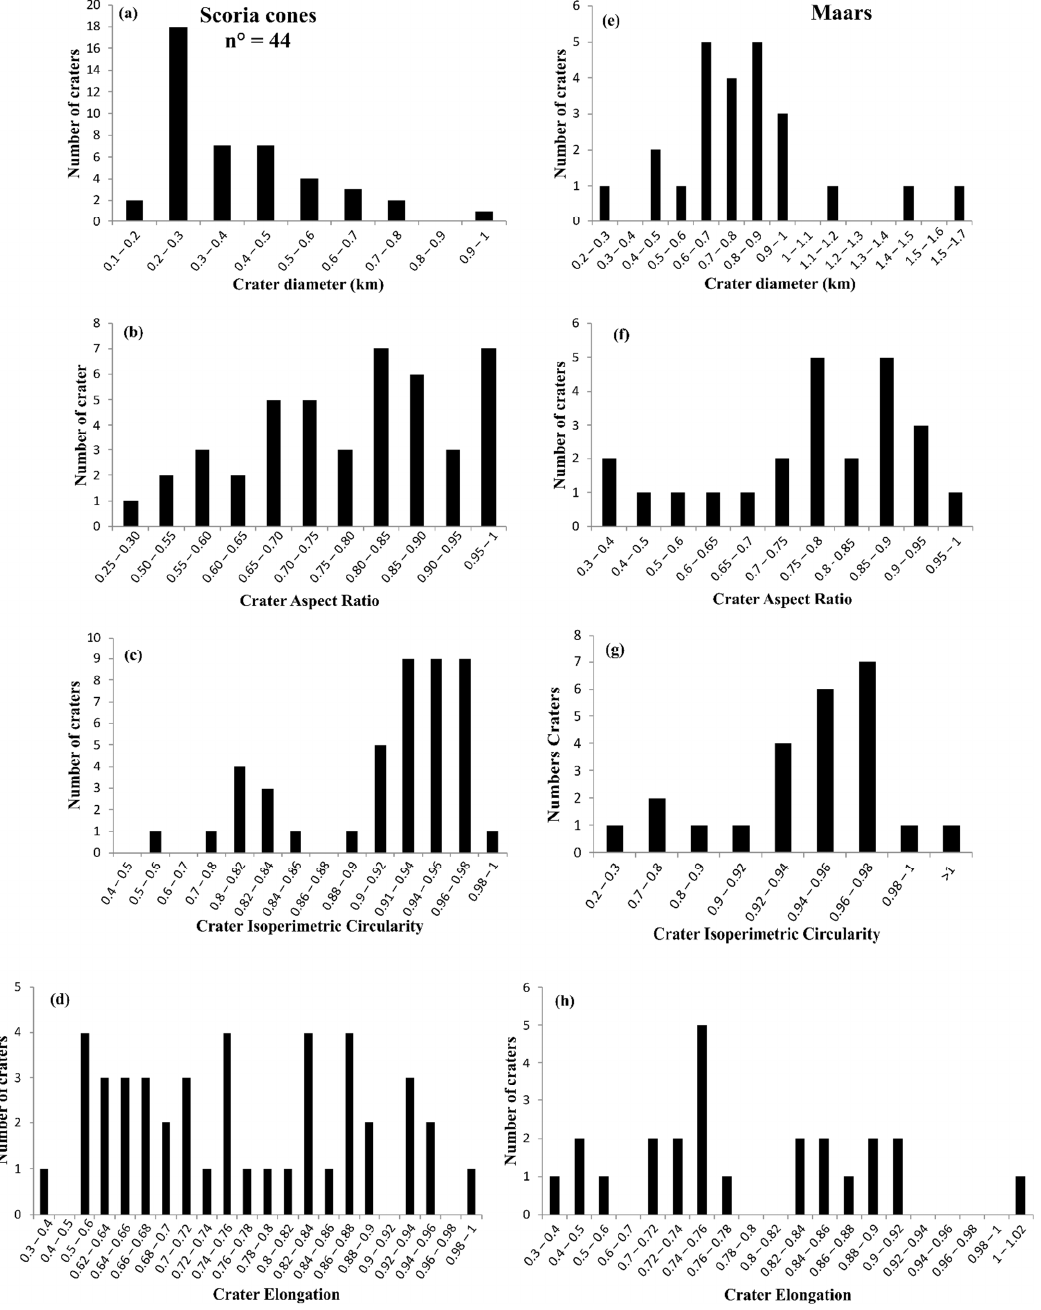
Figure 6. Histograms of craters in MAVF database (Tables 1 and 2) including size, distribution, and shape.